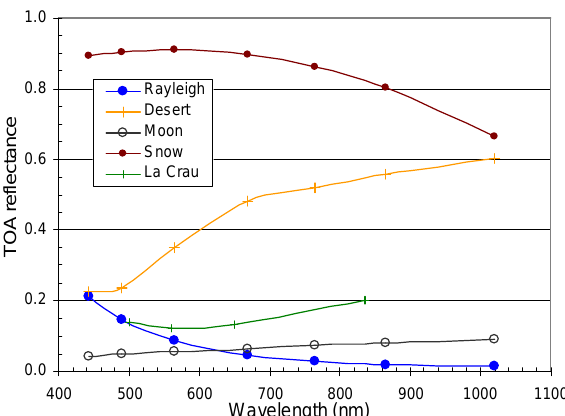
Figure 2. TOA reflectance of the different calibration sites.